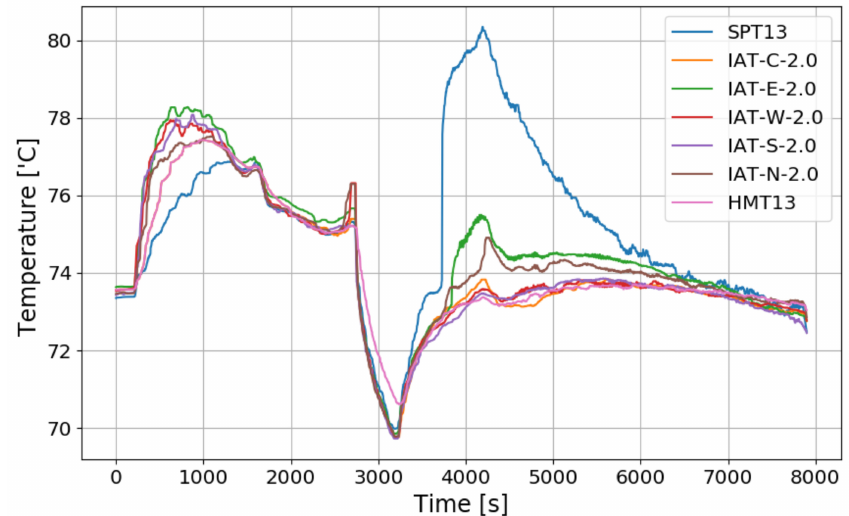
Figure 6. Comparison of gas temperatures. SPT13: PAR inlet; IAT-C-2.0: center of the vessel at 2 m height; IAT-E-2.0, IAT-W-2.0, IAT-S-2.0, and IAT-N-2.0: east, west, south, and north from the center of the vessel at 2 m height, respectively; HMT13: inside of the T-type connector (see Figure